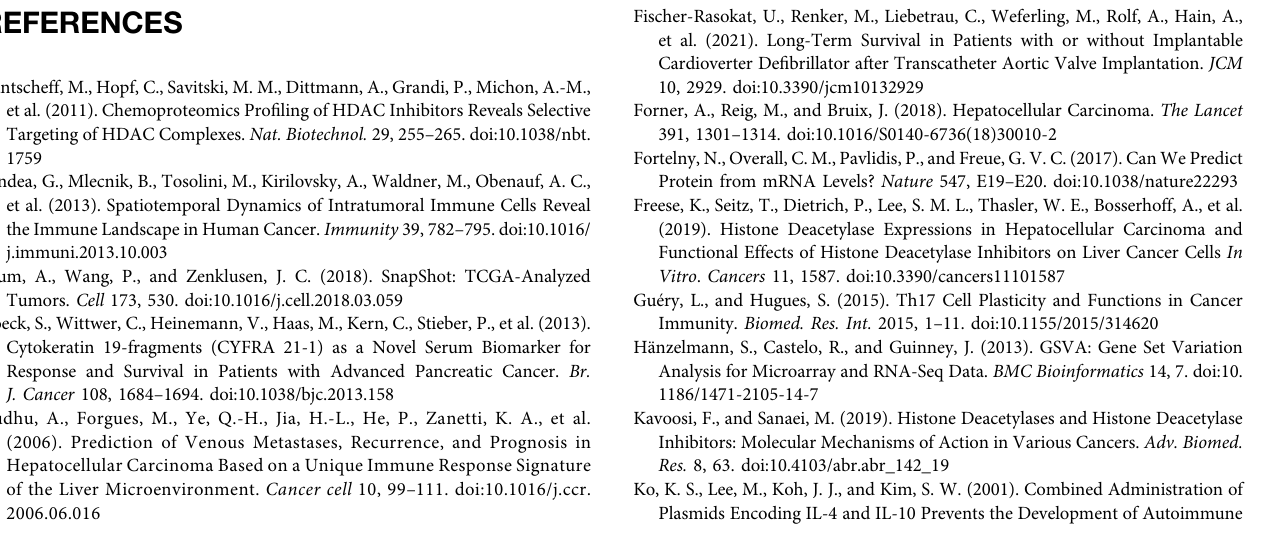
Supplementary Figure 1 | Volcano plot of differentially expressed RNAs. (A) Volcano plot of differentially expressed mRNAs. (B) Volcano plot of differentially expressed lncRNAs. Supplementary Figure 2 | Association between DNTTIP1 expression and different clinicopathological characteristics after post hoc Dunn ’ s test with Bonferroni correction for pairwise comparisons. (A) Association between DNTTIP1 expression and the T stage of HCC, (B) pathologic stage, (C) histologic grade, and (D) Fibrosis Ishak score. Supplementary Figure 3 | Nomogram and calibration curve. (A) Nomogram that integrated DNTTIP1 and independent clinical risk factors between tumor status and DNTTIP1. (B) Predictions made by the calibration curve were found to conform well to the ideal